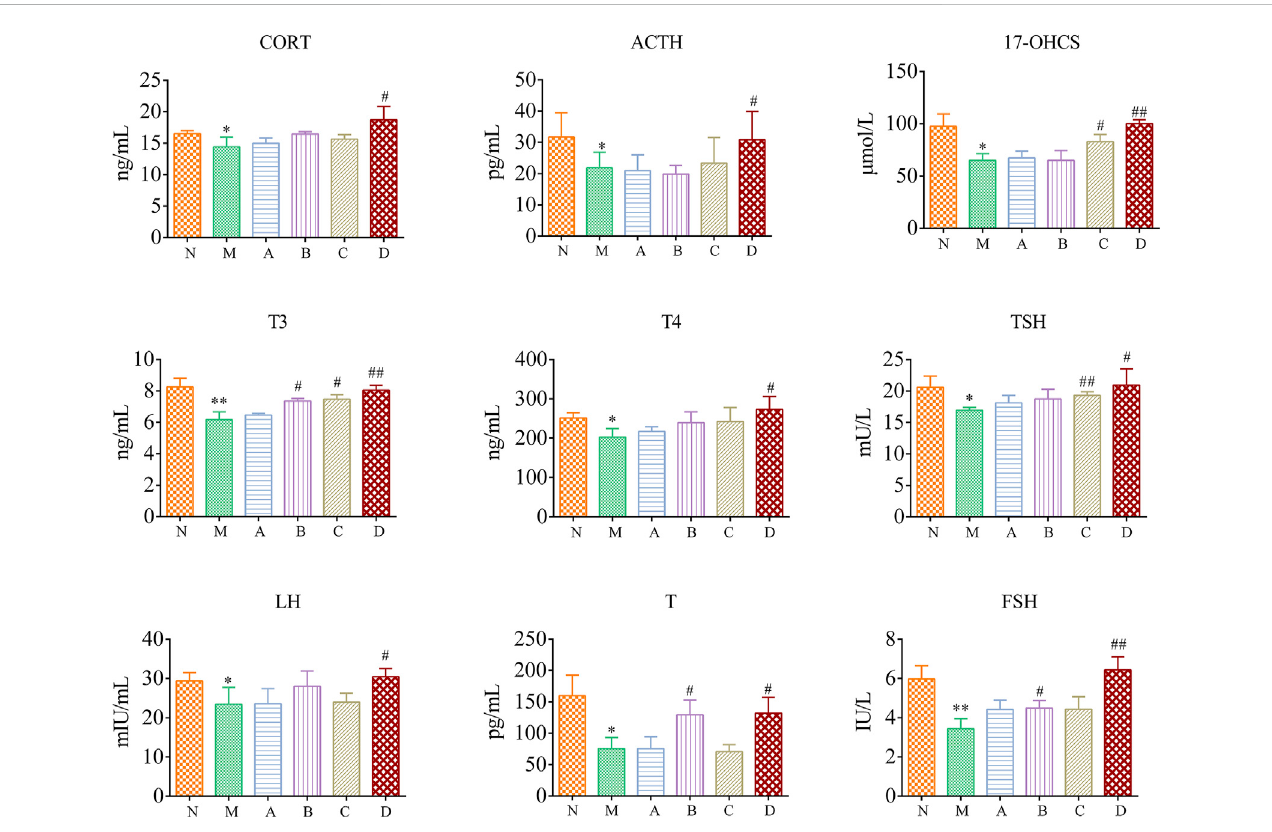
FIGURE 2 Biochemicalindexesinkidney-yangde fi ciencyratsN,normalgroup;M,modelgroup;A,suetoilgroup;B,Epimediumrawproductgroup;C,Epimedium heating product group; D, Epimedium fried with suet oil group. Signi fi cance compared to N group, * p < 0.05, ** p < 0.01; Signi fi cance compared to M group, # p < 0.05, ## p <